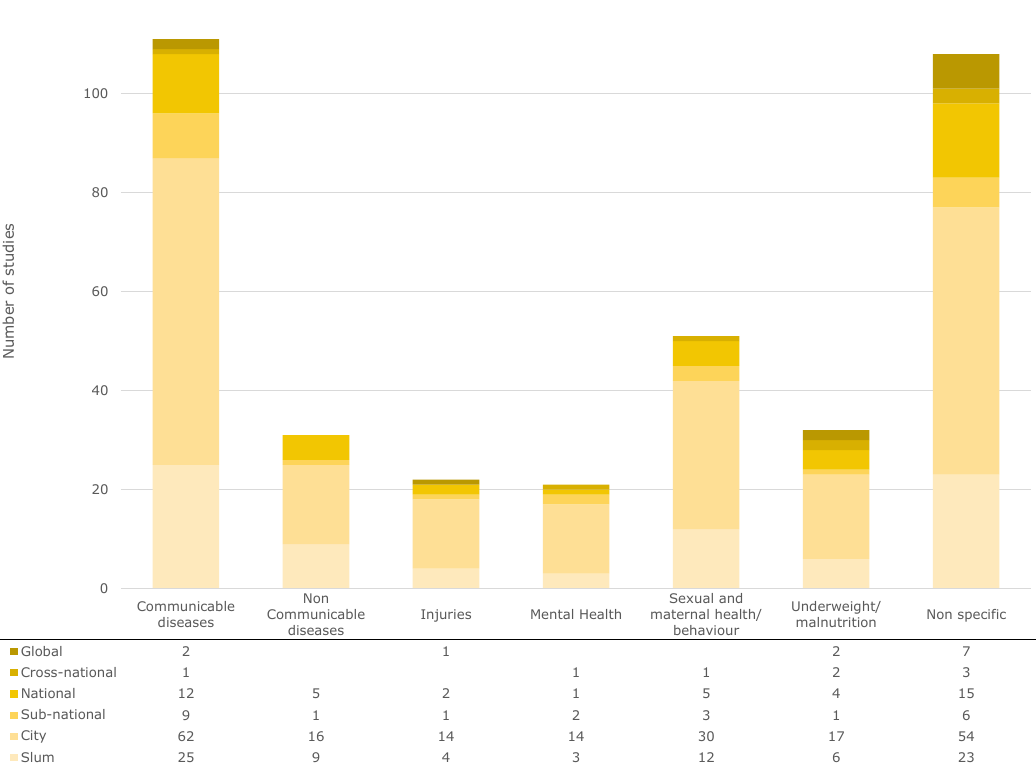
Figure 3. Categorization of the investigated studies into different spatial and medical